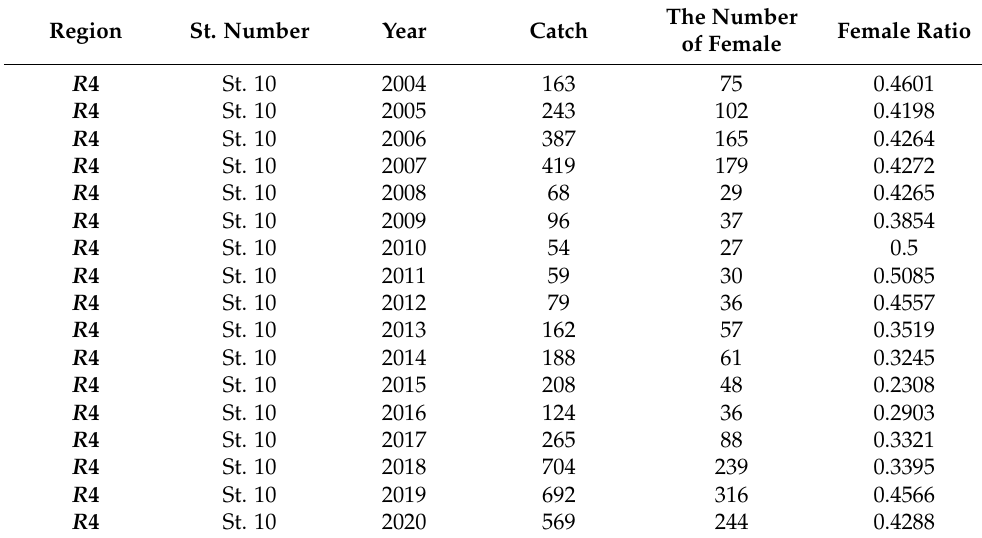
Table A4. The catch of chum salmon ( Oncorhynchus keta ) individuals and the number of females (Female ratio) in the R 4 region.